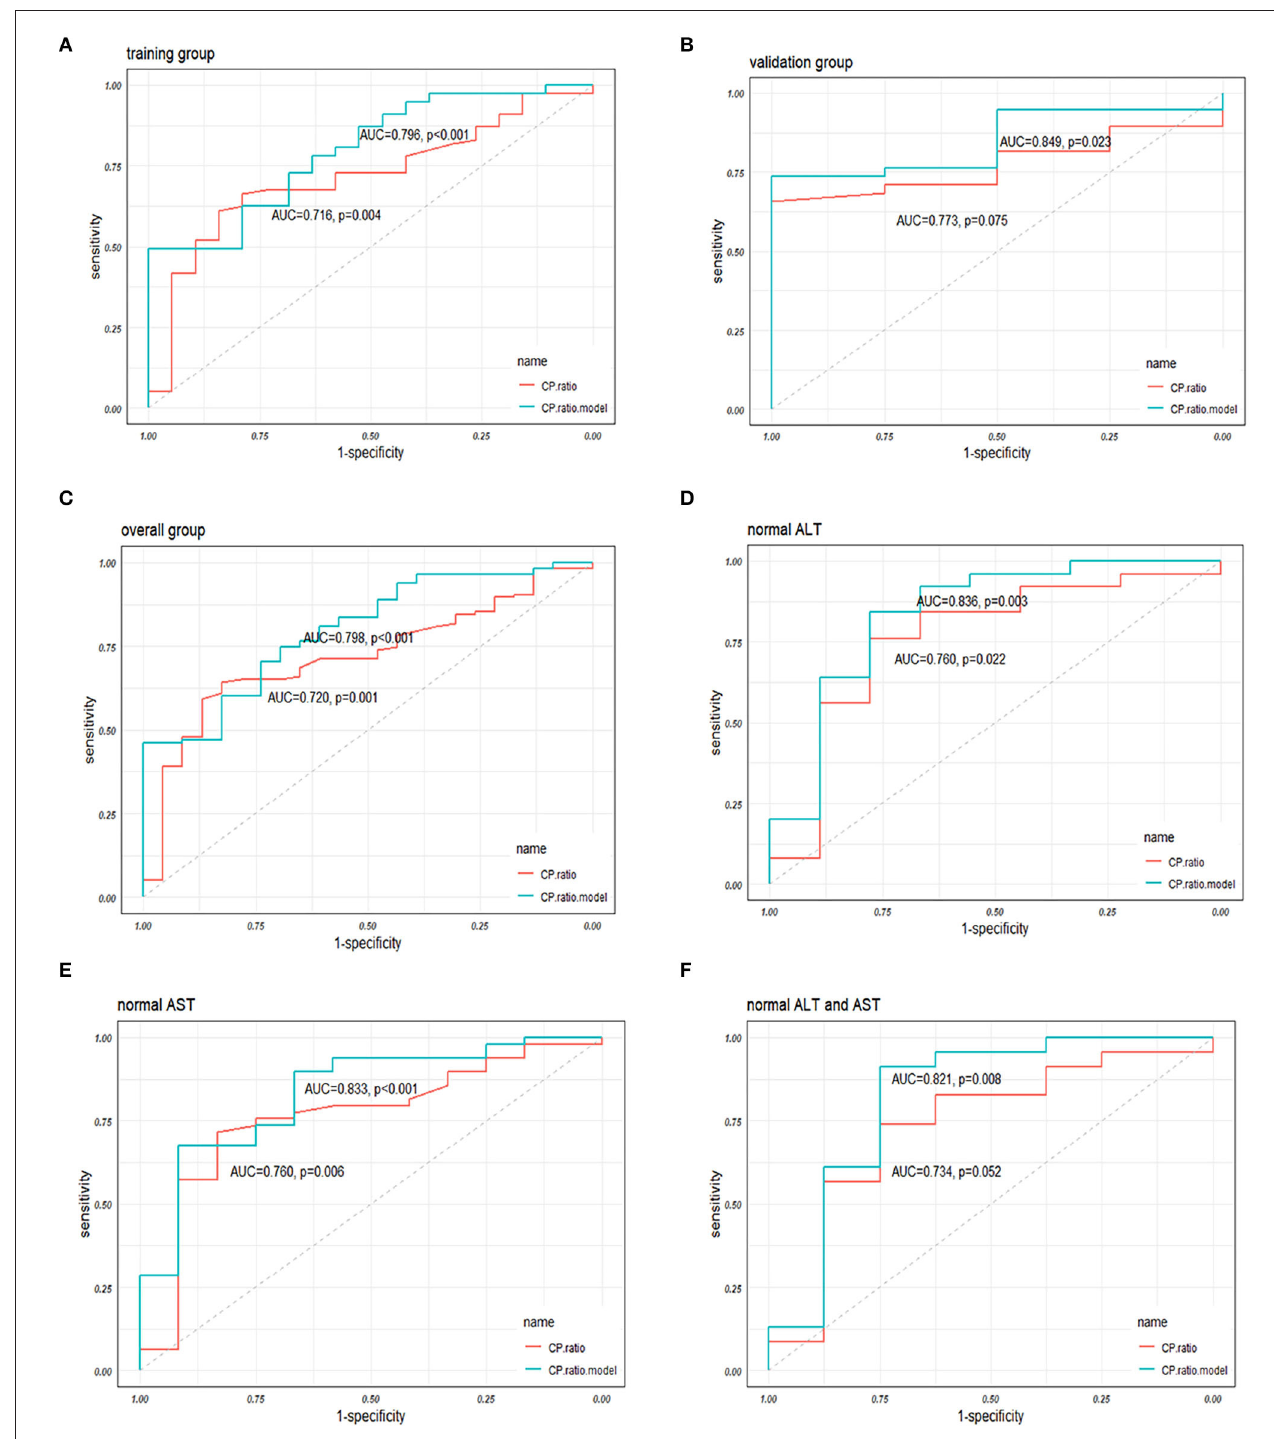
FIGURE 4 | The performances of the CP ratio and the CP ratio model in discriminating NASH in (A) the training, (B) validation, and (C) overall groups, and in patients with (D) normal ALT, (E) AST, and (F) both normal levels. Abbreviations: ALT, alanine transferase; AST, aspartate transferase; AUC, area under the receiver operator characteristic curve; CP, ceruloplasmin; NASH, nonalcoholic steatohepatitis; ROC, receiver operator characteristic curve.